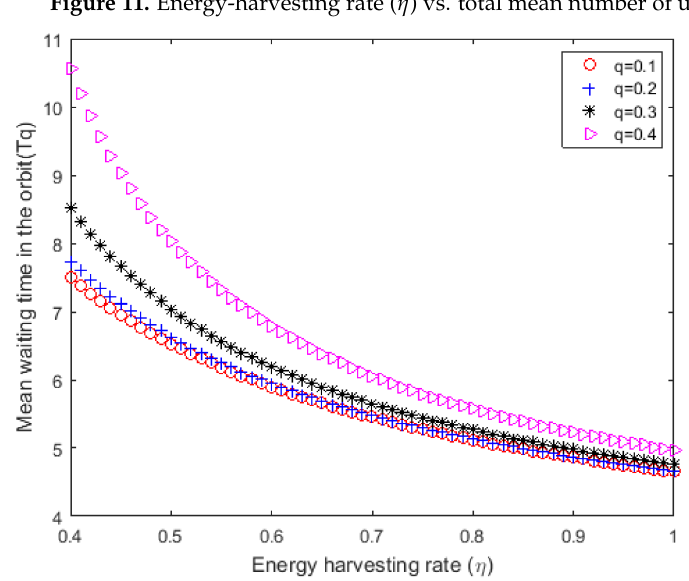
Figure 12. Energy-harvesting rate ( η ) vs. total waiting in